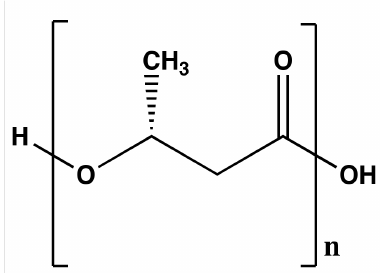
Figure 1. General structure of poly- β -hydroxybutyrate.